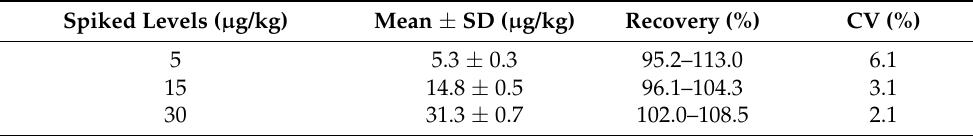
Table 3. Intra- and inter-day studies of AFB1 determination in distillers’ grain Table 2. The recovery rates of LFIA for AFB1 determination ( n = 6). Table 2. The recovery rates of LFIA for AFB1 determination ( n = 6).